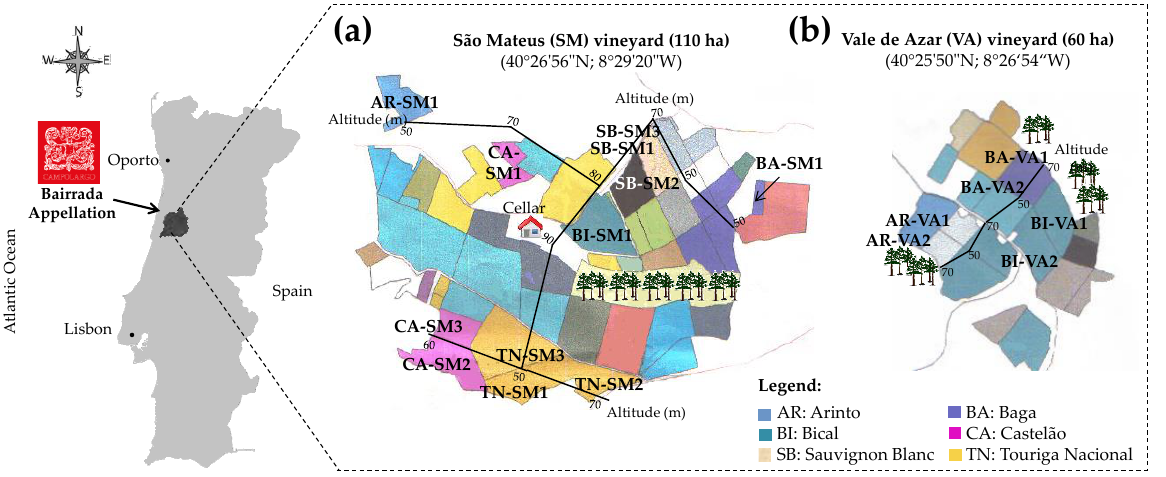
Figure 1. Representative scheme of the location of the vineyards of ( a ) São Mateus (SM) and ( b ) Vale de Azar (VA) at Manuel dos Santos Campolargo, Herdeiros company, in Bairrada Appellation (Portugal), highlighting the varieties ( Vitis vinifera L cv. Arinto (AR), Bical (BI), Sauvignon Blanc (SB), Baga (BA), Castelão (CA), and Touriga Nacional (TN)), altitude (ca. 50 to 90 m), and vineyard parcels (SM1 to SM3 and VA1 and VA2) under study.